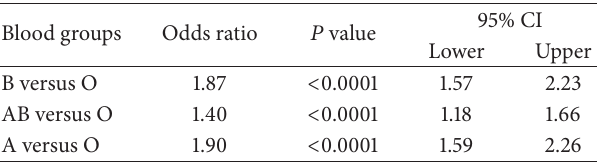
Table 3: Effect of blood group on developing complicated falci- parum